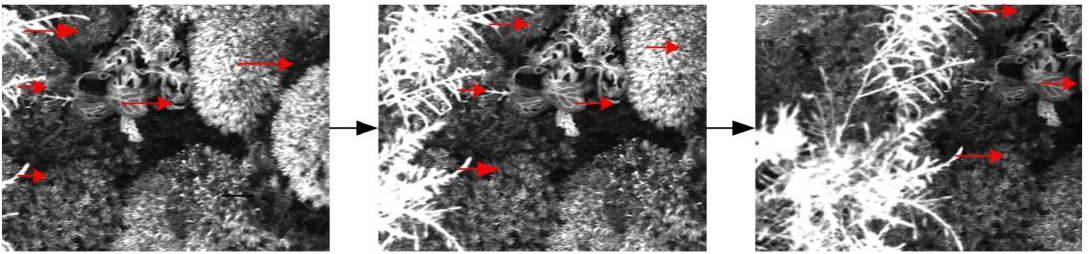
Figure 20. Optical-flow-direction diagram.